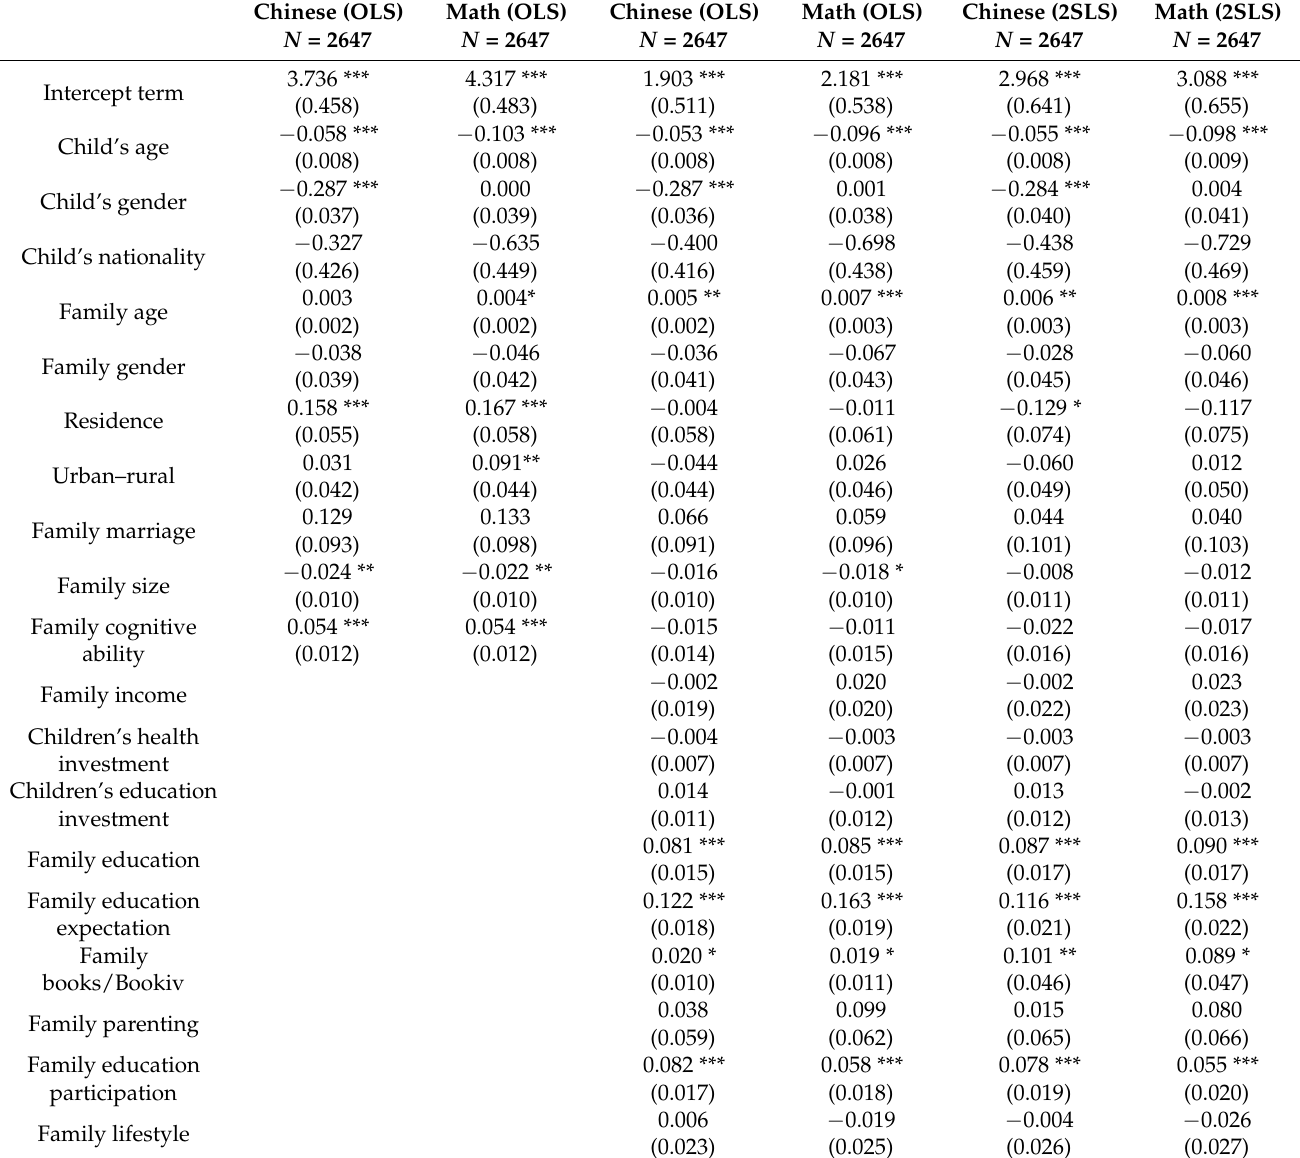
Table 2. Results for the influence of many factors on children’s cognitive